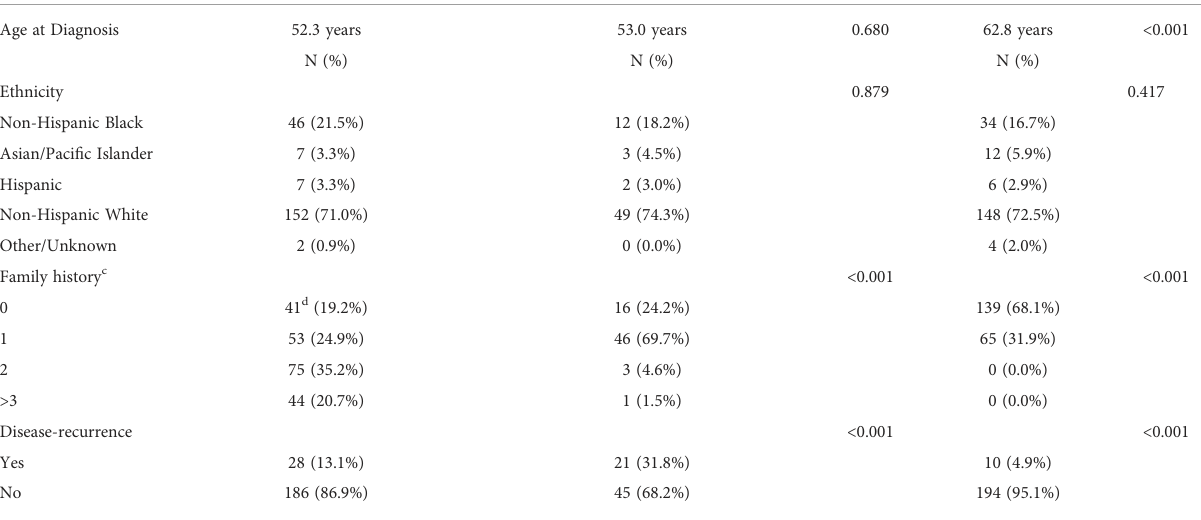
52.3 years 53.0 years 0.680 62.8